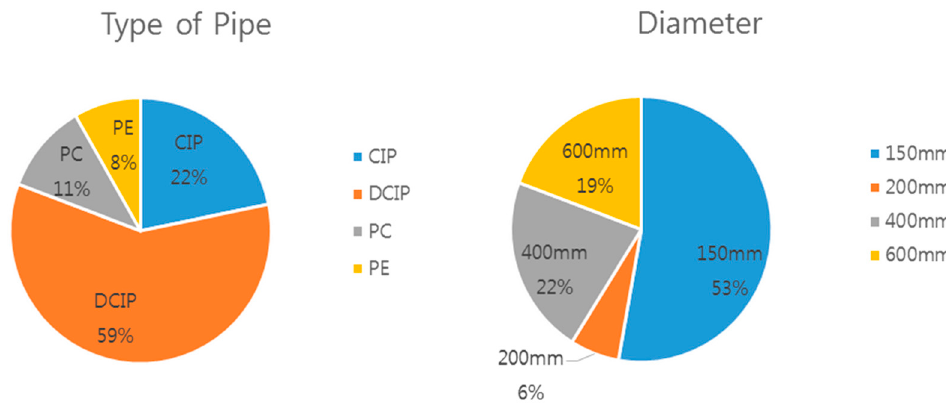
Figure 5. Characteristics of water conveyance pipes.